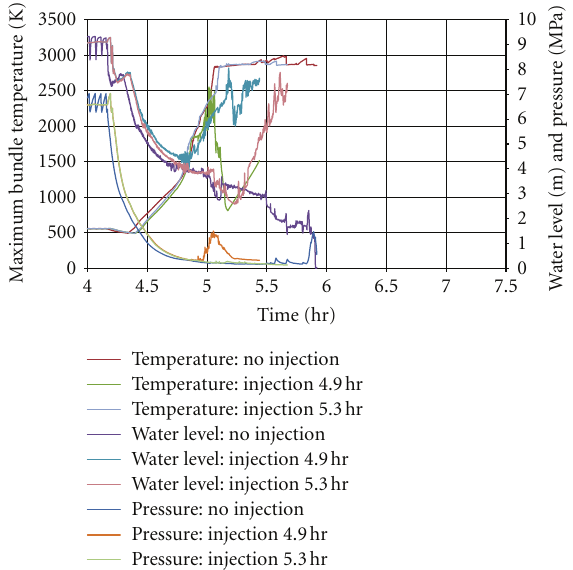
Figure 23: Maximum bundle temperature, water level, and reactor vessel pressure for scenarios with and without water injection after the start of core uncovery (all emergency water injection was terminated at 4.2 hours after reactor scram).